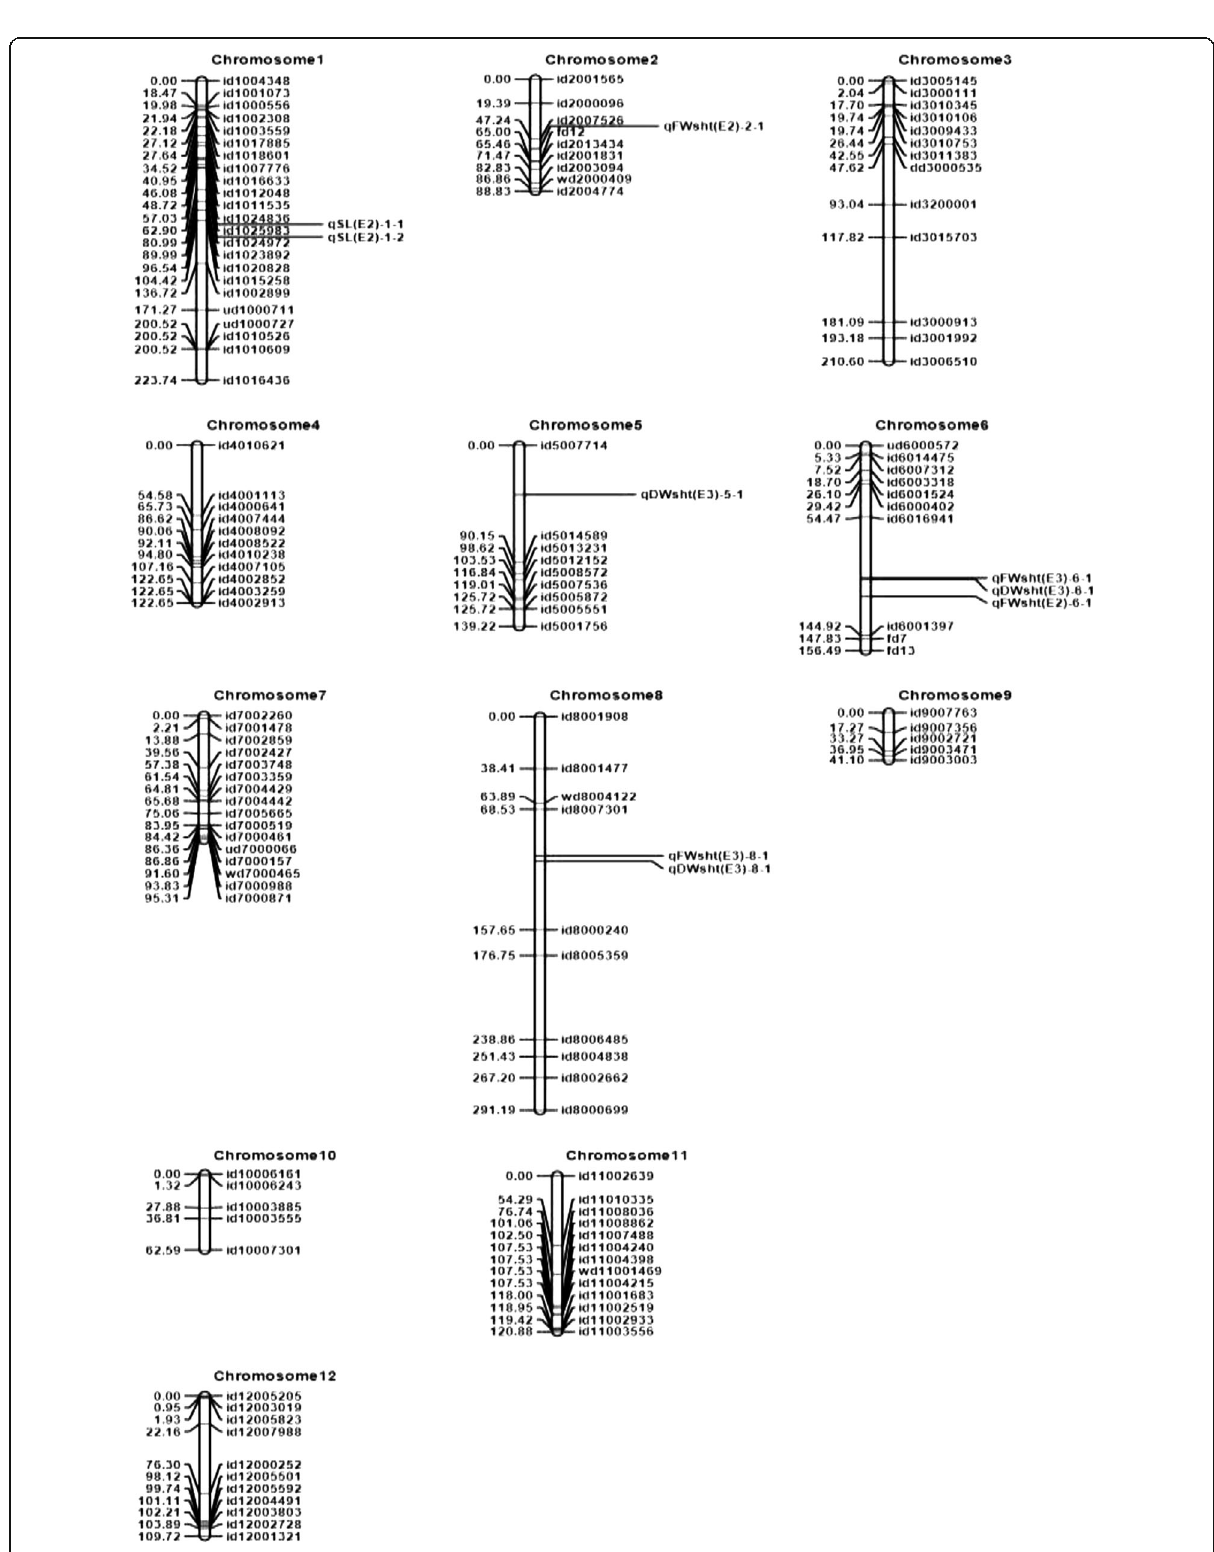
Fig. 2 Genetic linkage maps of the 12 chromosomes constructed using ordering algorithm (RECORD) based on an IR29/Hasawi RIL population phenotyped in Senegal (E2) and Tanzania (E3). The names of the SNP markers with position are listed to the right and the approximate locations of the QTLs detected for salinity tolerance are shown to the left of the